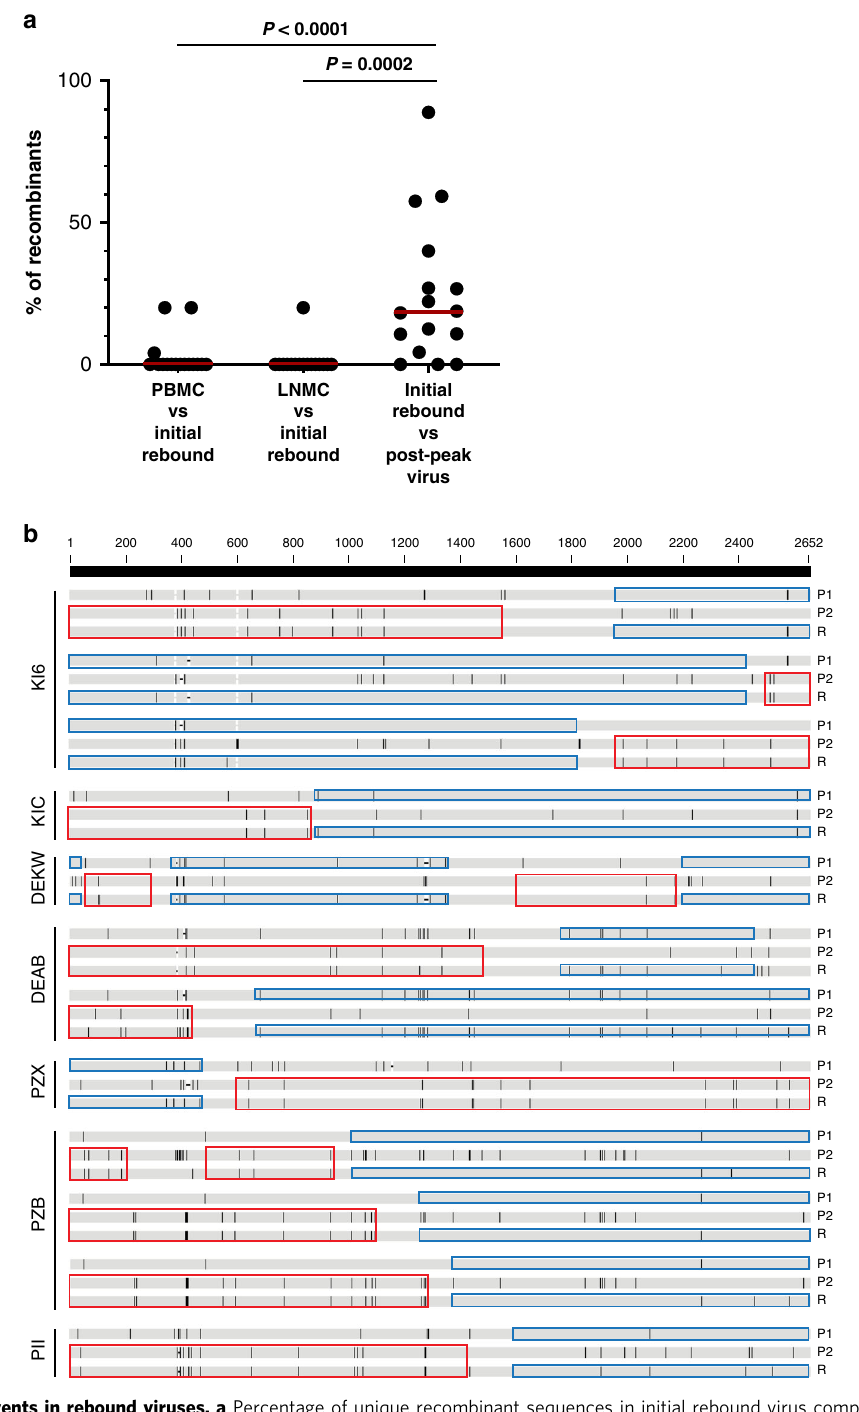
Fig. 6 Recombination events in rebound viruses. a Percentage of unique recombinant sequences in initial rebound virus compared to rcNFL viral DNA from PBMC and LNMC, and percentage of recombinant sequences in post-peak rebound virus compared to initial rebound virus. Red lines indicate median values ( n = 16). P values calculated using two-sided Mann – Whitney tests. b Post-peak recombinant env sequences identi fi ed by RAPR program (LANL database) from seven representative animals. Recombinants with the P values less than 0.0001 from the Wald-Wolfowitz test were shown here. Red and blue rectangles showed the similar regions of the recombinants (R) and the parental sequences (P1 and